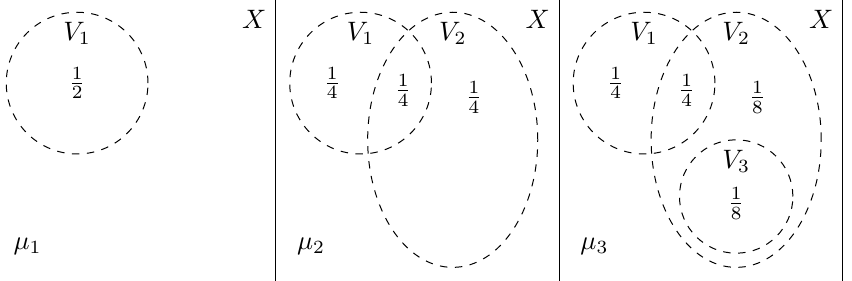
Figure 1. Behavior of the set functions ( µ k ) on ( A k